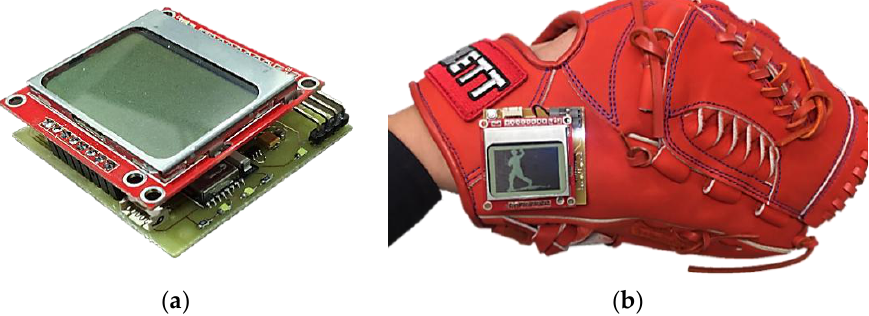
Figure 4. Display device of wearable assist system ( a ) LCD display device, ( b ) the device attached to the baseball glove. the baseball